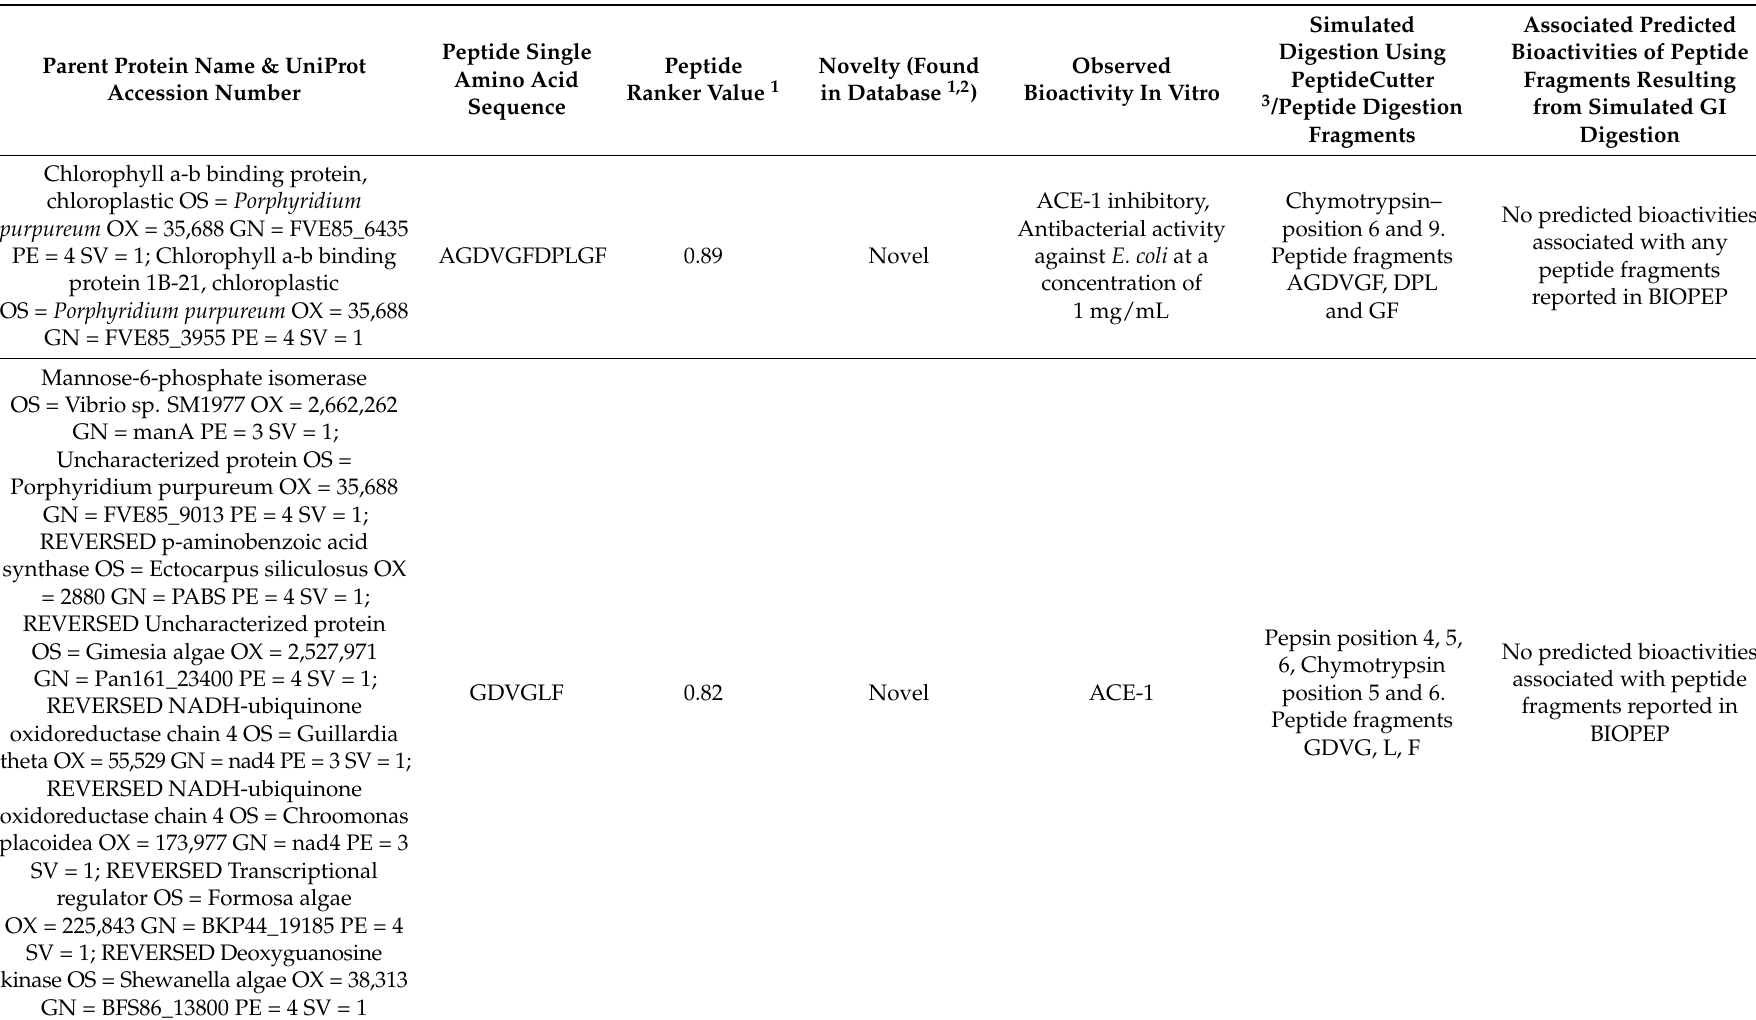
Table 2. Bioactive peptides identified from Nannochloropsis sp. protein xylanase treated permeate fraction and associated bioactivities of peptide fragments derived from the same peptides following simulated gastrointestinal digestion with Pepsin and Trypsin